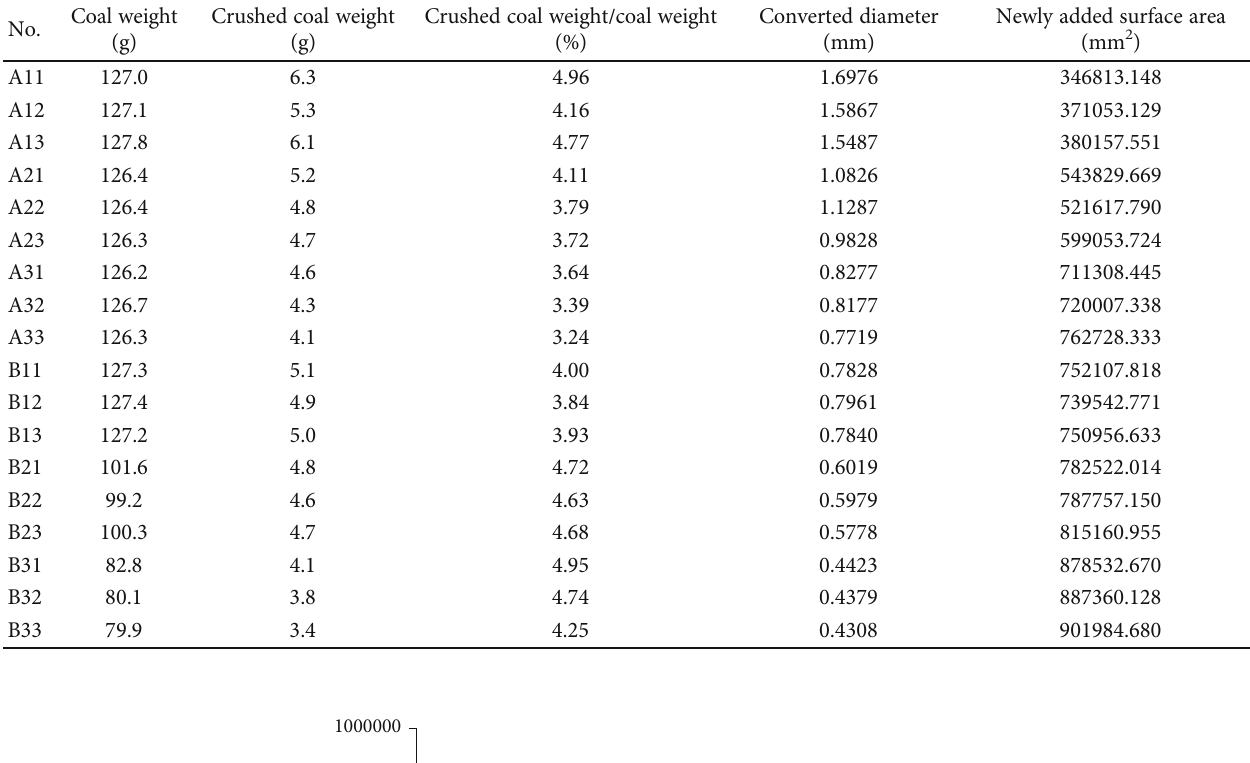
Table 4: The newly added surface area of the di ff erent combination samples.